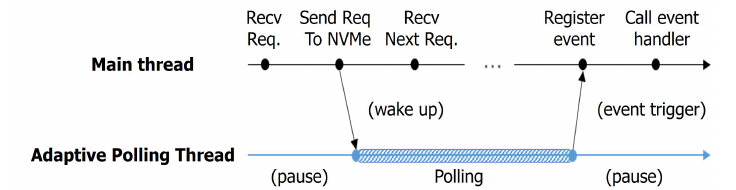
Figure 5. Adaptive polling mechanism: A separated polling thread is woken up with the consideration of the expected completion time.